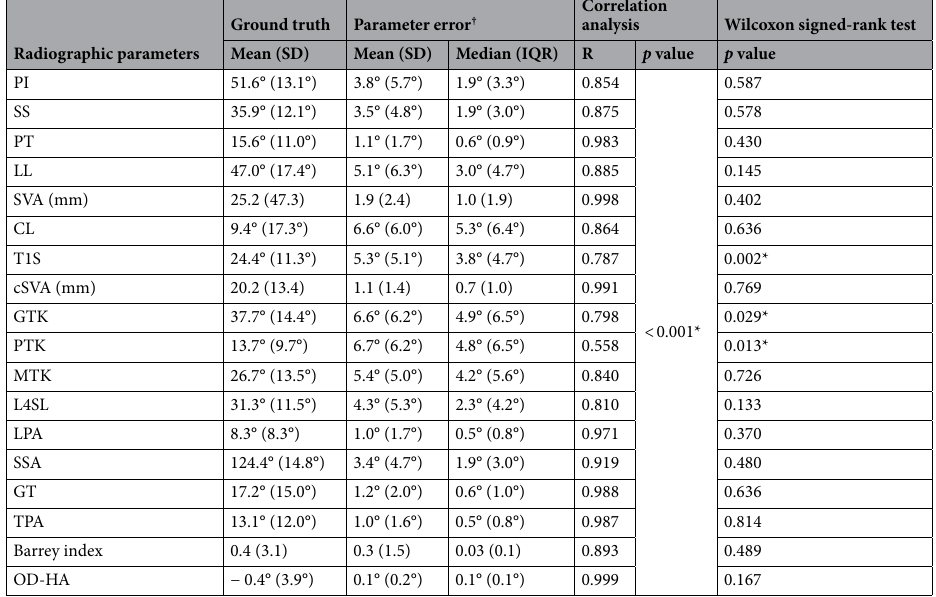
Table 1. Performance evaluation of the spinal radiographic parameters of the ensemble model. R Pearson correlation coefficient; SD standard deviation; IQR interquartile range, PI pelvic incidence; SS sacral slope; PT pelvic tilt; LL lumbar lordosis; SVA sagittal vertical axis; CL cervical lordosis; T1S T1 slope; cSVA cervical sagittal vertical axis; GTK global thoracic kyphosis; PTK proximal thoracic kyphosis; MTK main thoracic kyphosis; L4SL L4-S1 lordosis; LPA lumbar pelvic angle; SSA spino-sacral angle; GT global tilt; TPA T1 pelvic angle; OD-HA odontoid hip axis. * p value < 0.05. † Absolute difference between the prediction and the ground